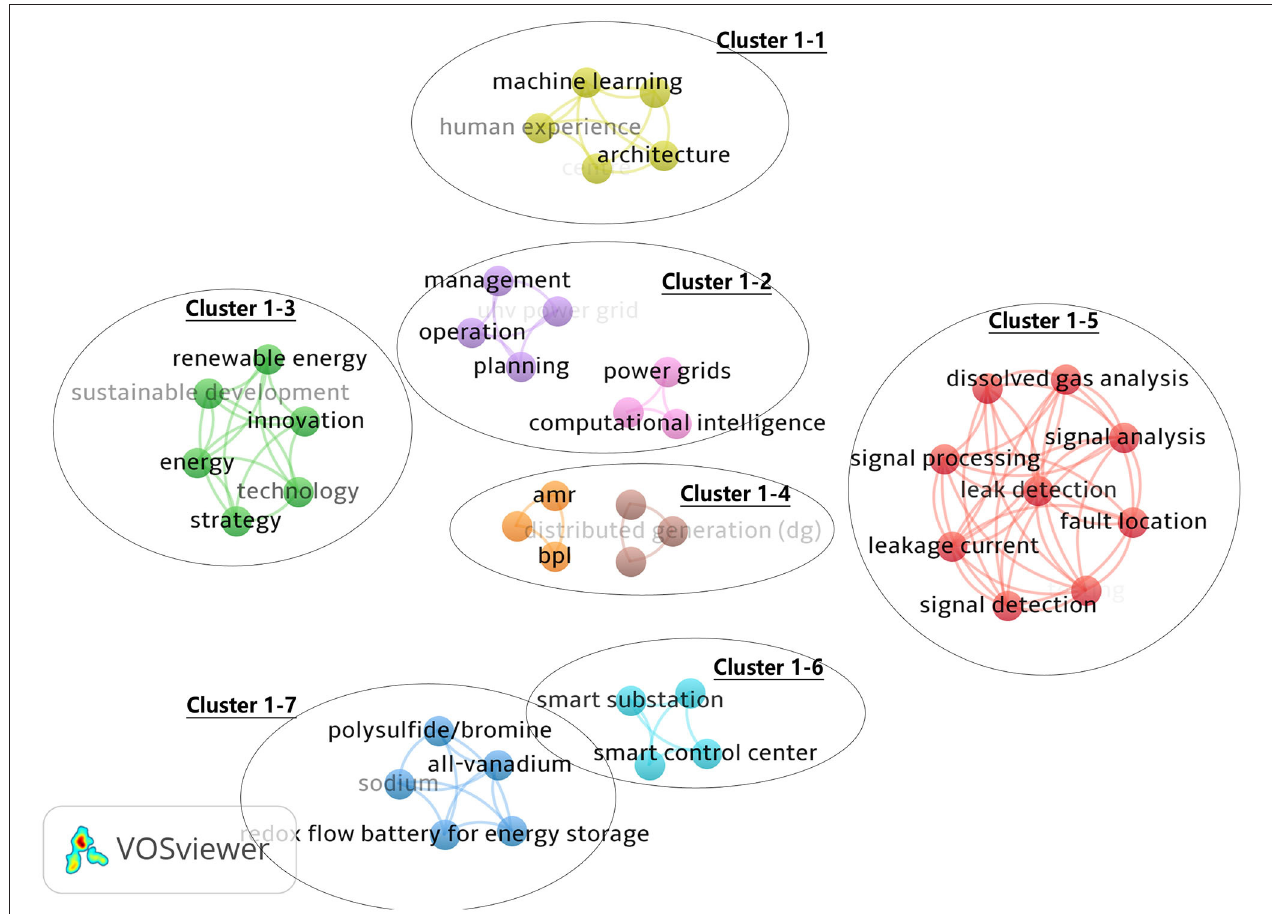
FIGURE 8 | Author-keyword co-occurrence network of SG publications in China, 2008–2009. A total of 42 keywords, VOSviewer parameters: minimum occurrence is 1, normalization method: LinLog/modularity, attraction = 3, repulsion = 0, clustering: resolution = 1min. The cluster size: 1. Search keywords such as smartgrid, smart grid, and smart grids are not